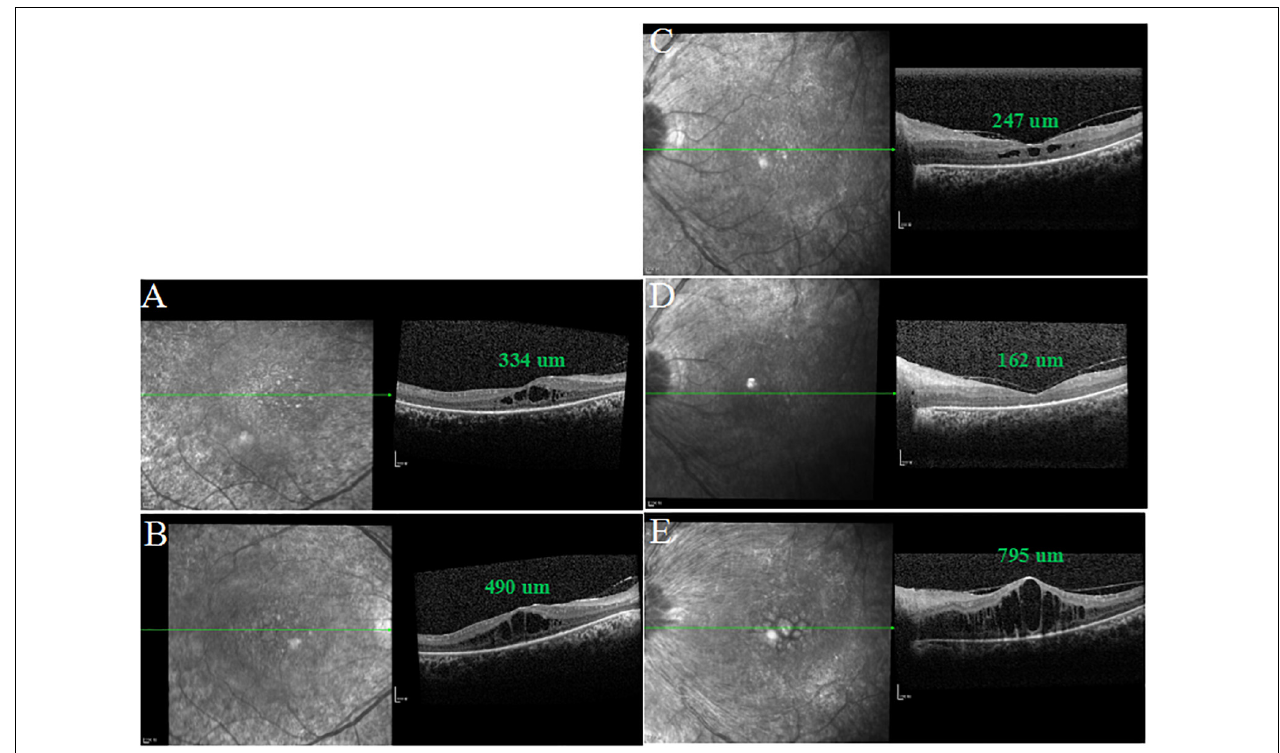
FIGURE 4 | SD-OCT images of both eyes after intravitreal injection of aflibercept in the left eye. (A,D) One month after treatment, CMT was 334 µ m in the right eye and macular edema (ME) of the left eye completely disappeared. (C) One week after treatment, CMT was 247 µ m in the left eye. (B,E) Three months after treatment, CMT was 490 µ m in the right eye and ME of the left eye